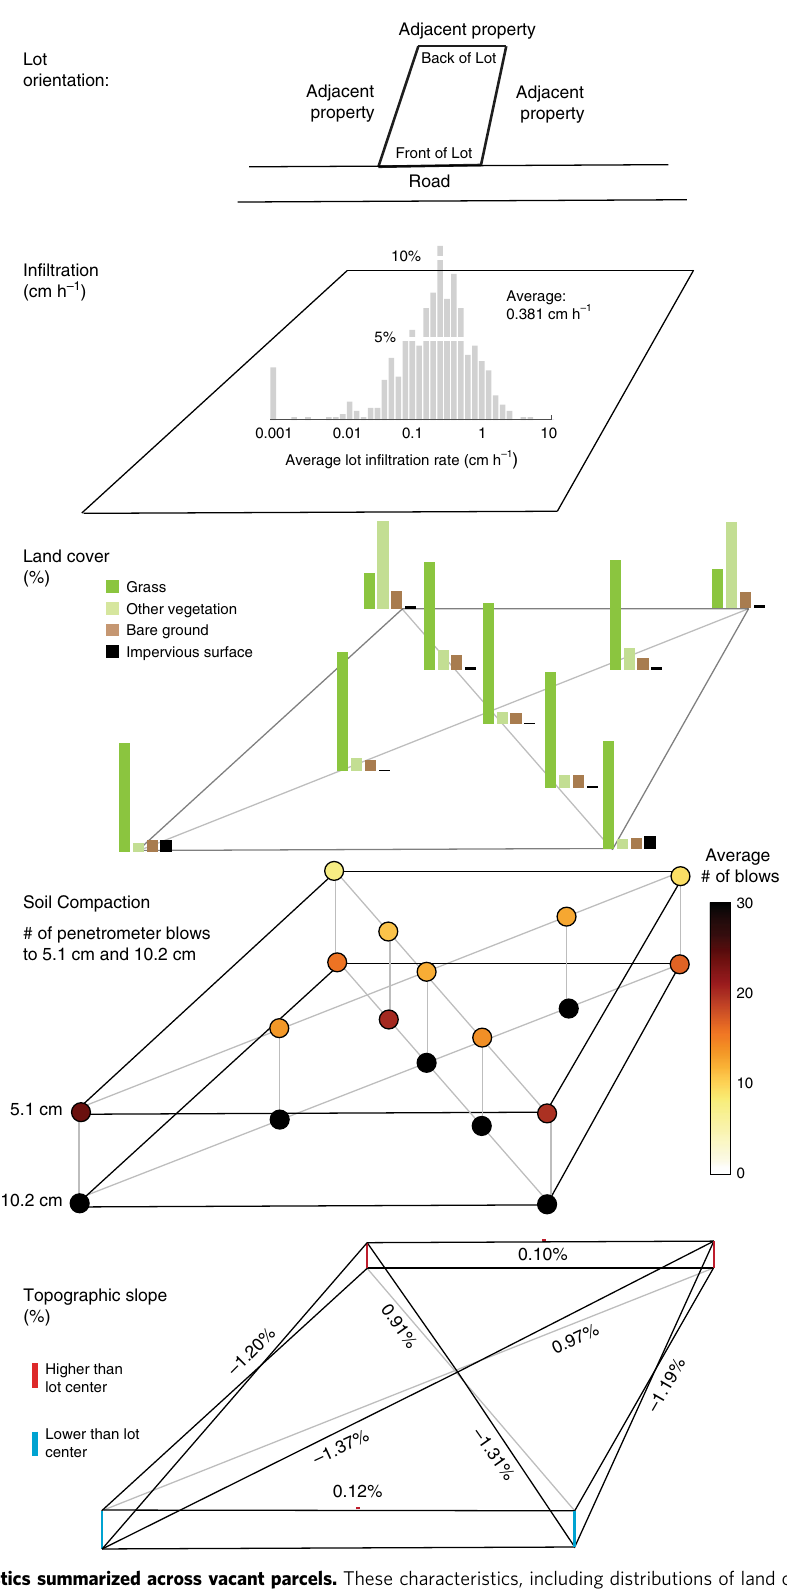
Fig. 3 Sub-parcel characteristics summarized across vacant parcels. These characteristics, including distributions of land cover ( n = 709), average soil compaction ( n = 715), and average topographic slope ( n = 713), will interact with in fi ltration rate ( n = 520) to favor in fi ltration versus runoff on vacant parcels. These characteristics, measured and mapped at multiple sites across each lot, reveal the conventional form and functional presentation of vacant